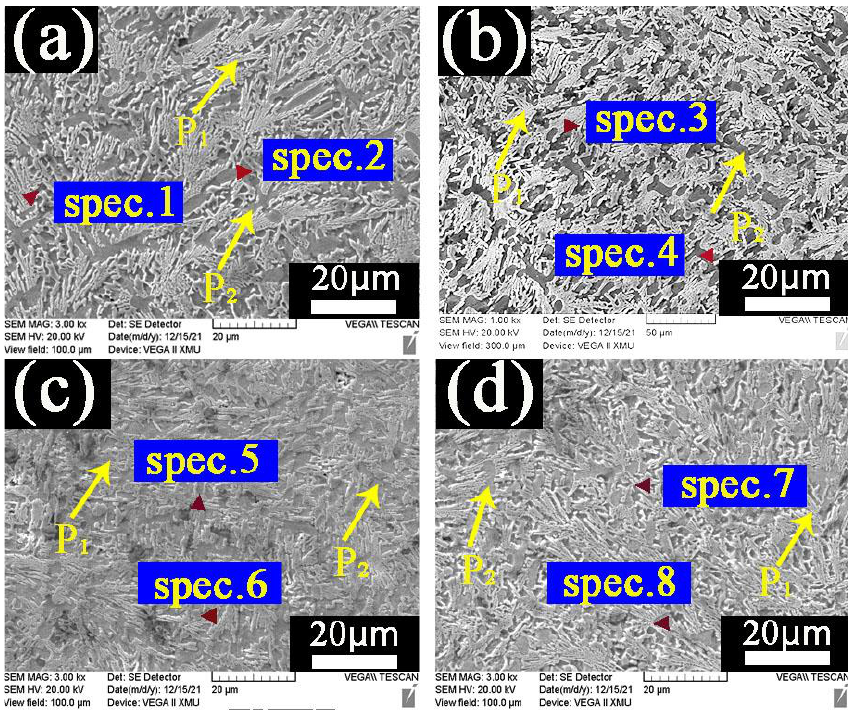
Figure 2. Microstructures of the composite coatings with different thermal treatment temperatures.